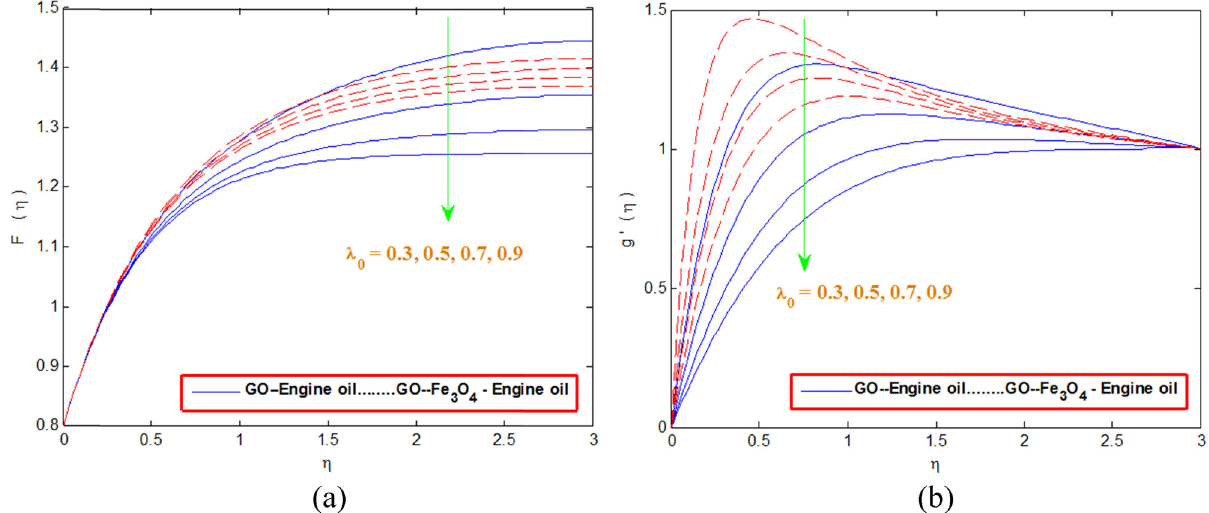
Figure 5: Change in ( a ) velocity and ( b ) induced magnetic fi eld with λ 0 .